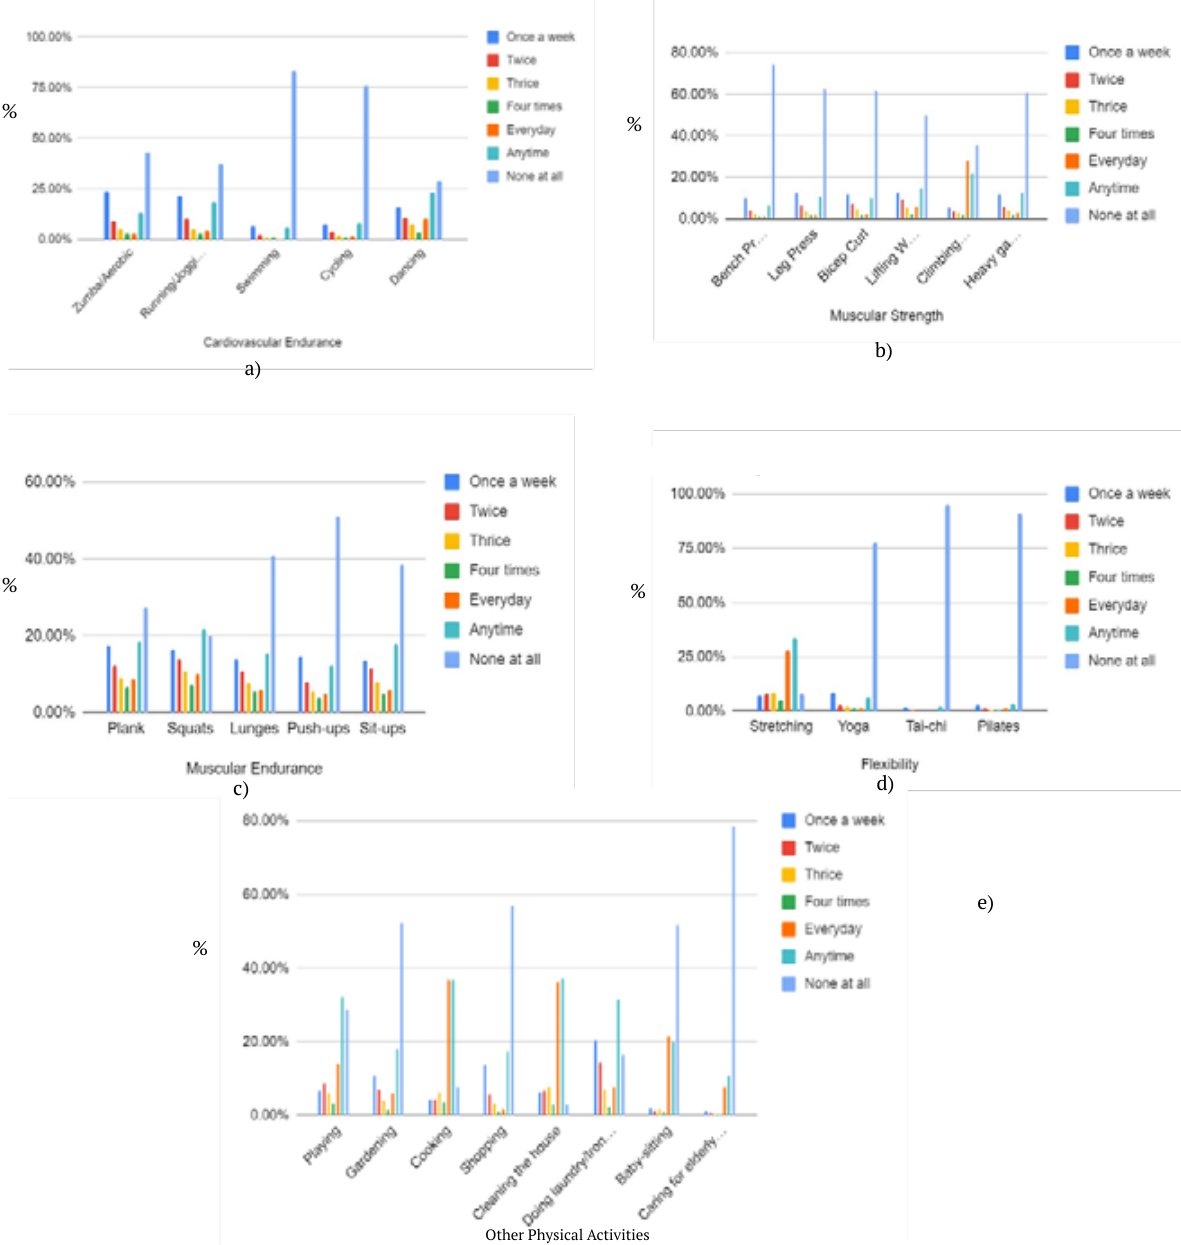
Figure 1. Physical Activities performed during the quarantine period: a) – Cardiorespiratory Endurance; b) – Muscular Strength; c) - Muscular Endurance; d) - Flexibility; e) – Other Physical